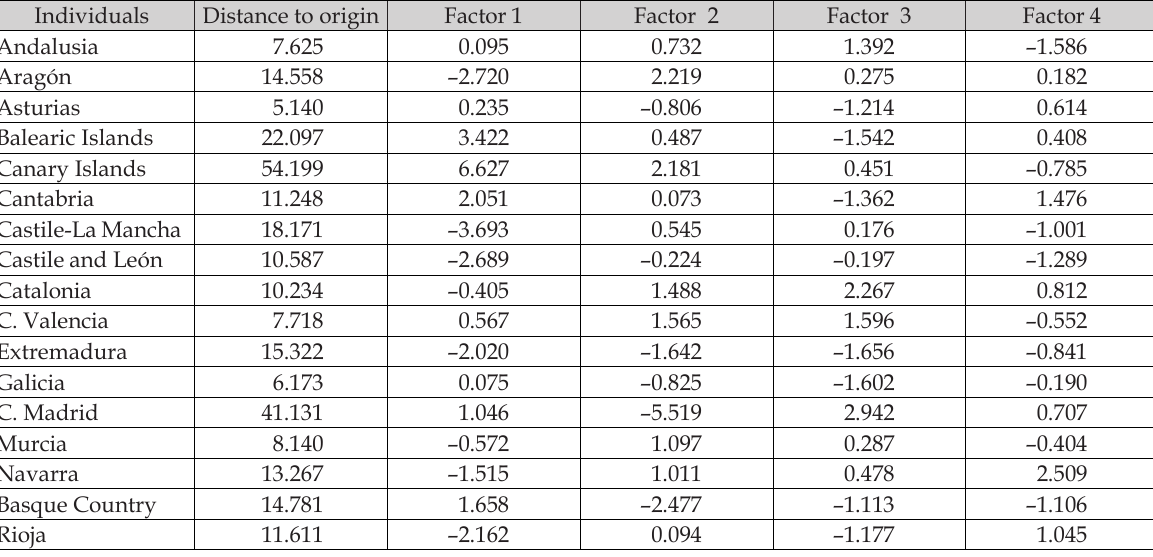
Table 2. Complete table of individual-factor